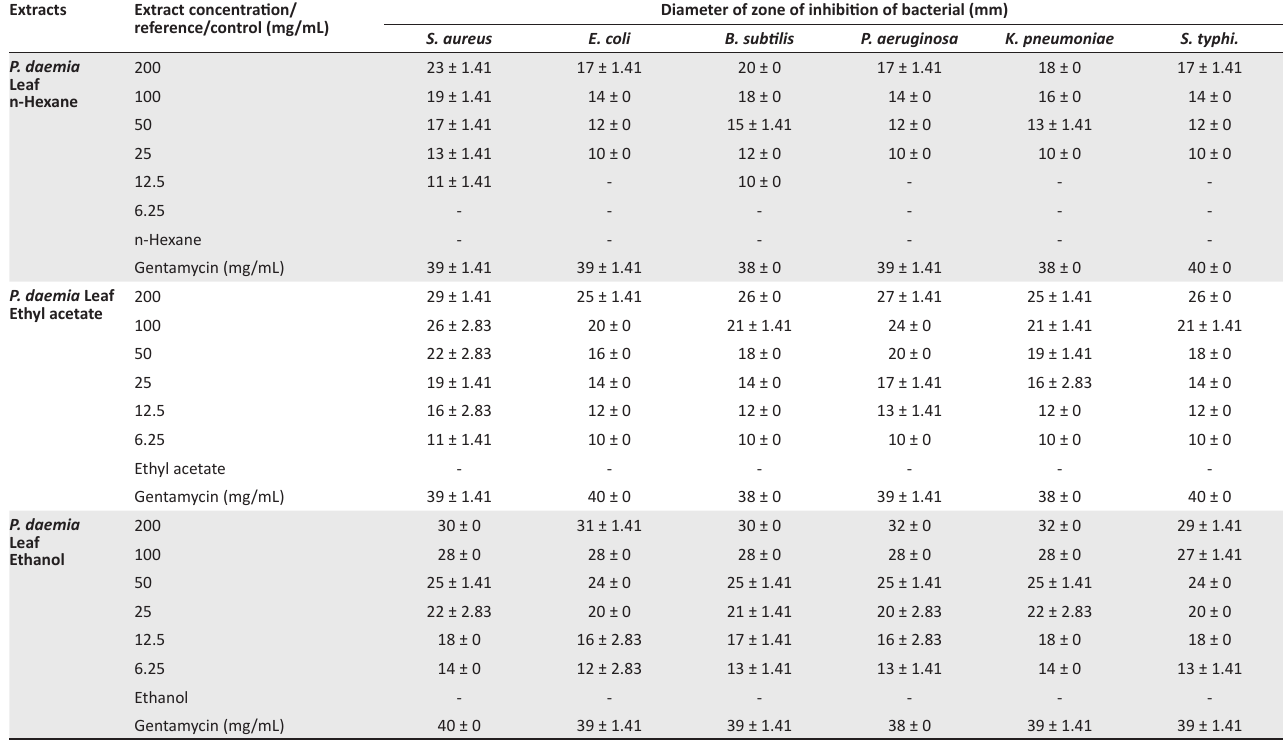
Diameter of zone of inhibition of bacterial